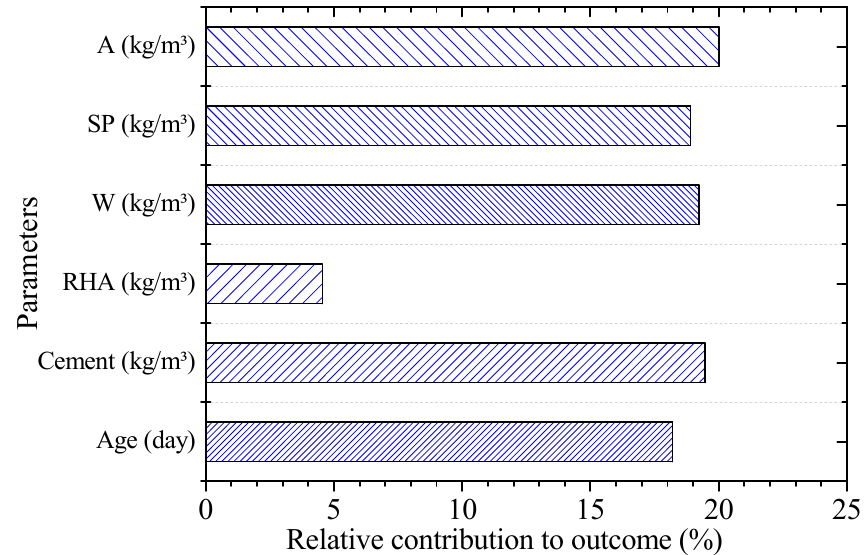
Figure 8. Contribution of inputs to the output.